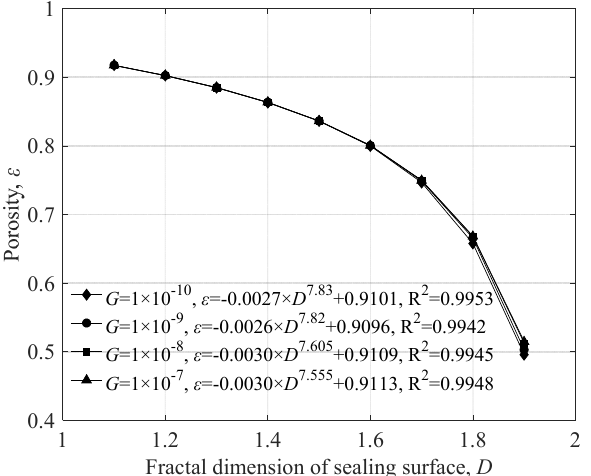
Figure 12. The influence of sealing surface fractal parameters on porosity.